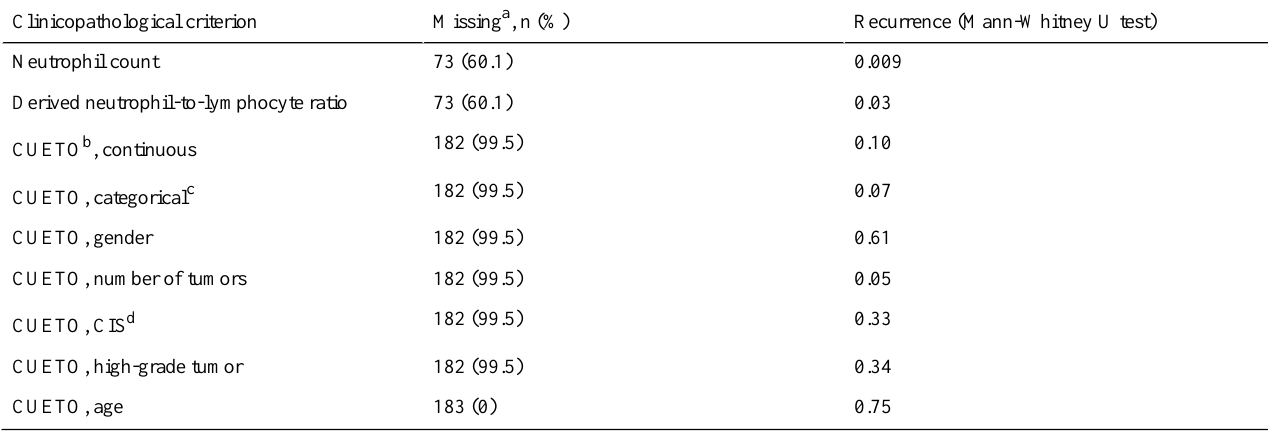
Table 3. Club Urológico Español de Tratamiento Oncológico scoring model or statistically significant clinicopathological criteria in univariate analysis among patients with intermediate- or high-risk non–muscle-invasive bladder cancer who received bacillus Calmette-Guérin (N=183) +1 to 180 days after